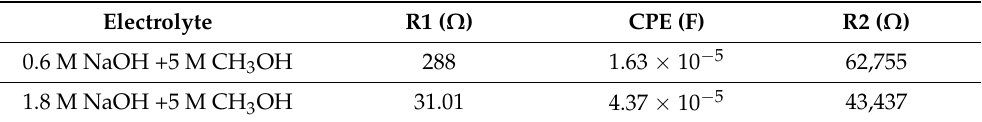
Table 1. Equivalent circuit parameters obtained from fitting of the Nyquist plots measured with PACHA coated gold electrodes in different concentrations of NaOH electrolyte containing 5 M CH 3